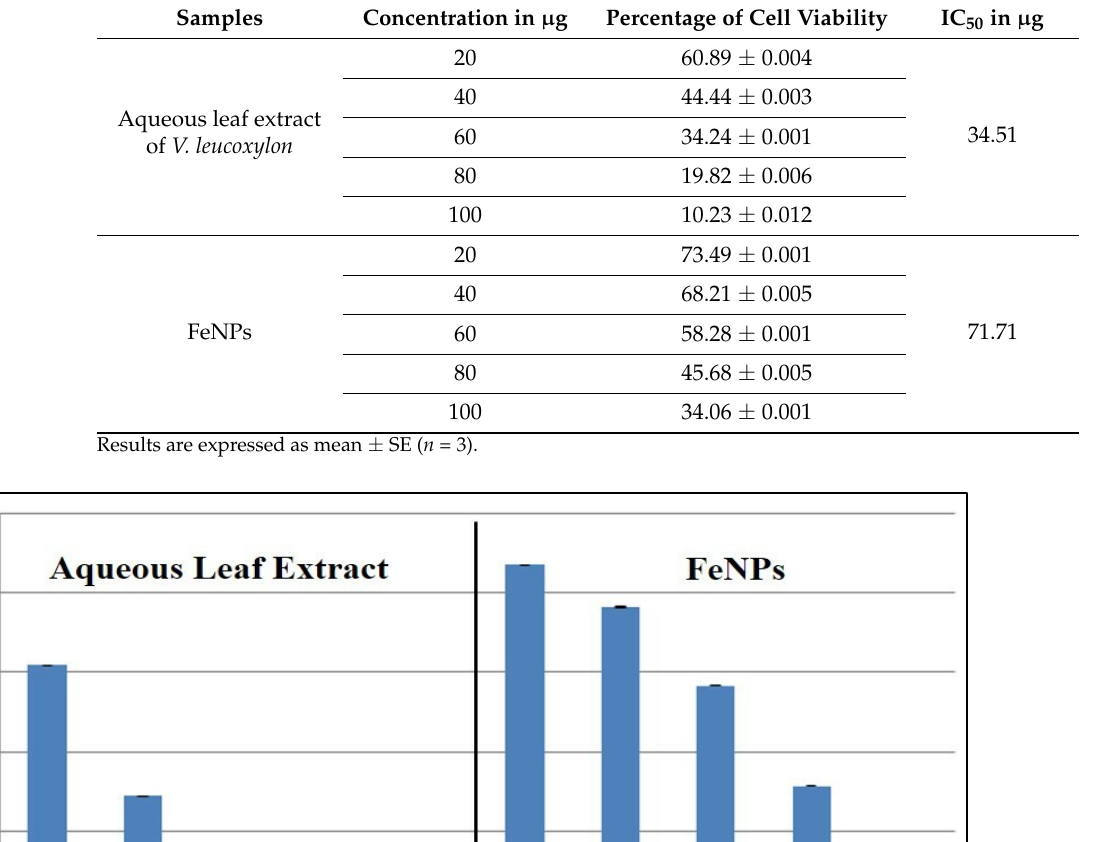
Table 7. Percentage of cell viability of aqueous leaf extract of V. leucoxylon and its synthesized iron nanoparticles against L929 cell line.